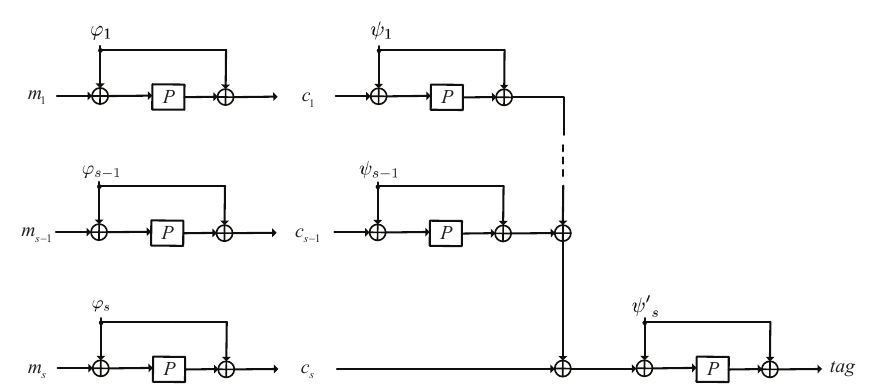
Figure 3: AEAD Mode of Minalpher with Empty Auxiliary Data and Non-empty